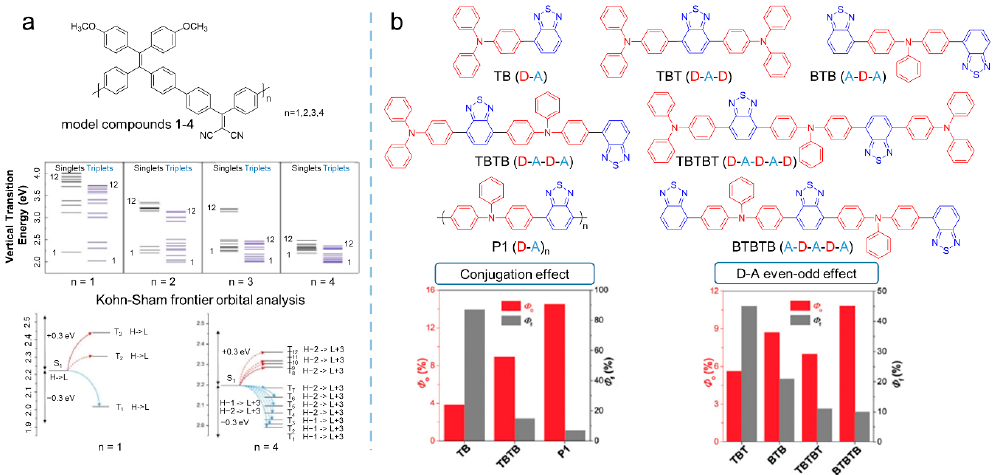
Figure 12. Polymerization strategy to enhance ROS generation. ( a ) Molecular structure of the model compounds, calculated energy levels, and possible ISC channels of different model compounds.